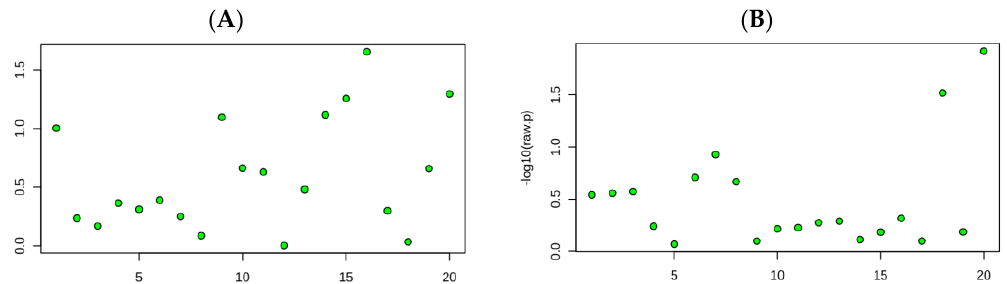
Figure 7. Important features selected by ANOVA plot with p -value threshold 0.05 for the lemon juice samples obtained in 9 different treatments (3 substrates × 3 rootstocks) related to ( A ) rootstock and ( B ) culture media.